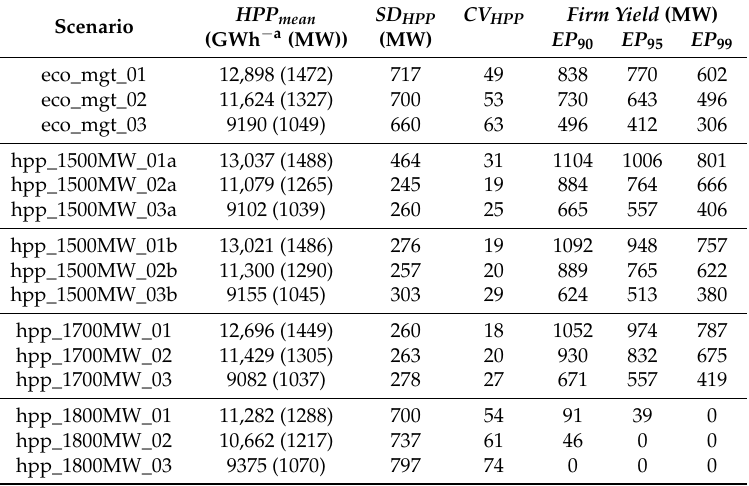
Table 4. HPP statistics during operation from